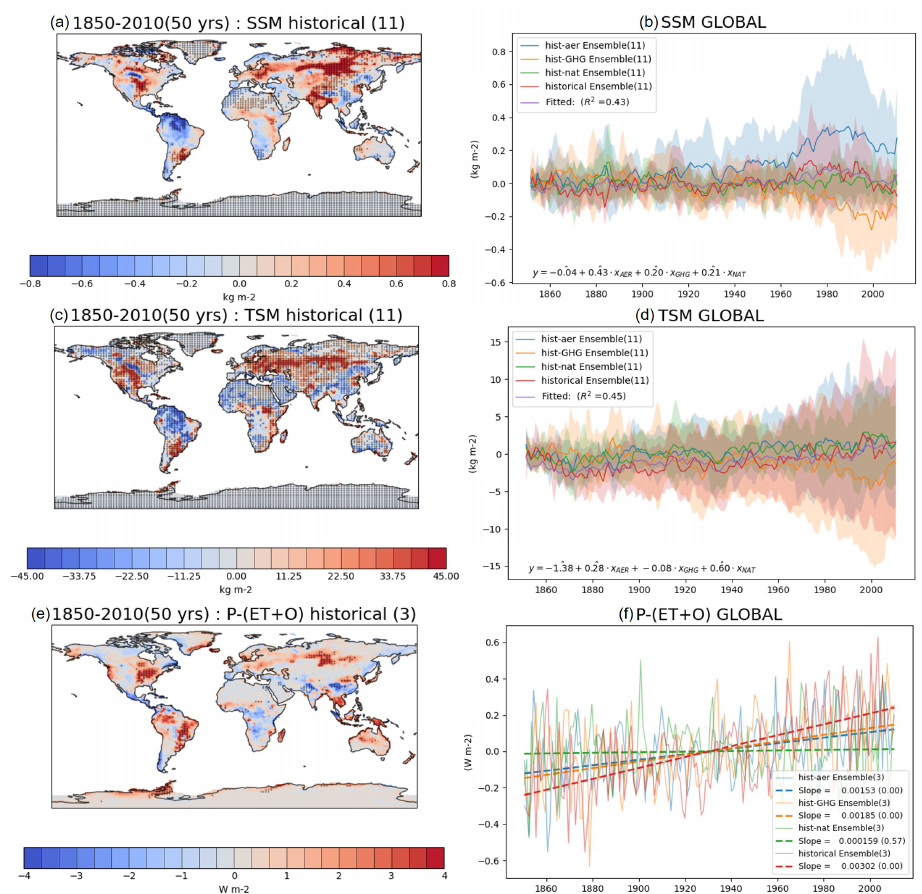
Figure 6. Results of surface soil moisture (SSM), total soil moisture (TSM), and water budget ( P − ( ET + O ) ) analyses, where O is the surface runoff: ( a ) 50-year mean start-to-end difference in SSM; ( b ) time series plot of global SSM; ( c ) 50-year mean start-to-end difference in TSM; ( d ) time series plot of global TSM; ( e ) 50-year mean start-to-end difference in P − ( ET + O ) ; ( f ) time series plot of global P − ( ET + O ) . The water budget was normalized by the whole-period average. The titles above the plots and the legends within the plots are followed by the number of ensemble models in parentheses, and the estimated parameters with hats indicate statistical significance. On the maps, dots indicate where the differences are significant ( p -value ≤